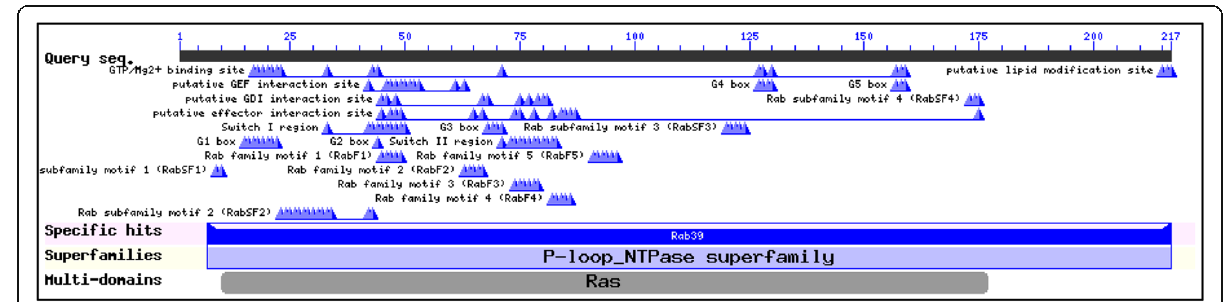
Fig. 2 The conserved domains of Rab39a protein: Basic local alignment search tool [12] illustrates that the residues from 28 to 54 are important for putative GEF interaction